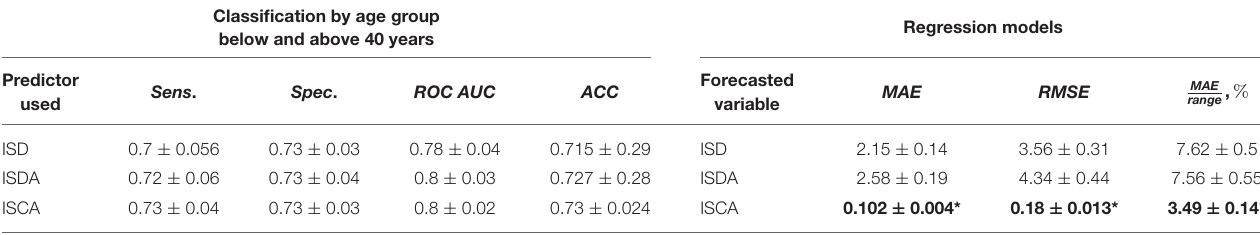
Regression models